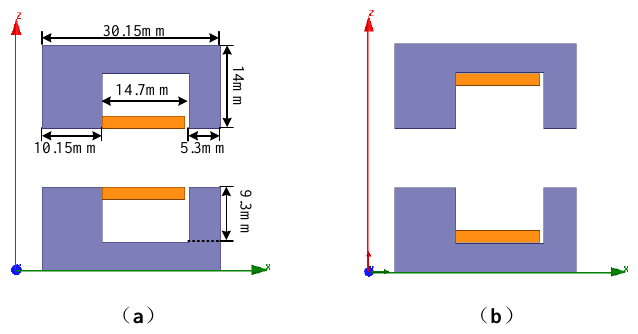
Figure 6. Position of the coils. ( a ) Top position; ( b ) Bottom position.